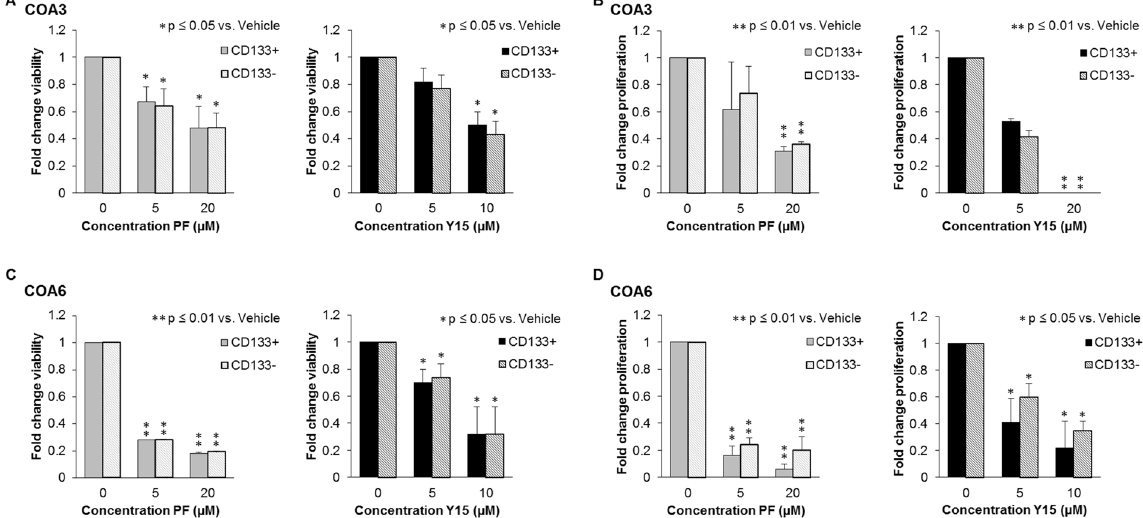
Figure 7. FAK inhibition led to decreased survival and proliferation in COA3 and COA6 sorted cell populations. COA3 and COA6 cells were sorted for CD133 using a magnetic cell sorting system. ( A ) COA3 CD133-enriched or CD133-depleted cells (1.5 × 10 4 ) were treated with increasing concentrations of PF (0, 5, 20 μ M) or Y15 (0, 5, 10 μ M) for 5 days and cell survival was measured using alamarBlue ® assay. There was a significant decrease in cell survival in both populations following treatment with PF and Y15. ( B ) COA6 CD133-enriched or CD133-depleted cells (1.5 × 10 4 ) were treated in the same fashion, and there was a significant decrease in cell survival following treatment with PF and Y15 in both populations. ( C ) COA3 CD133-enriched or CD133-depleted cells (5 × 10 3 ) were treated with increasing concentrations of PF or Y15